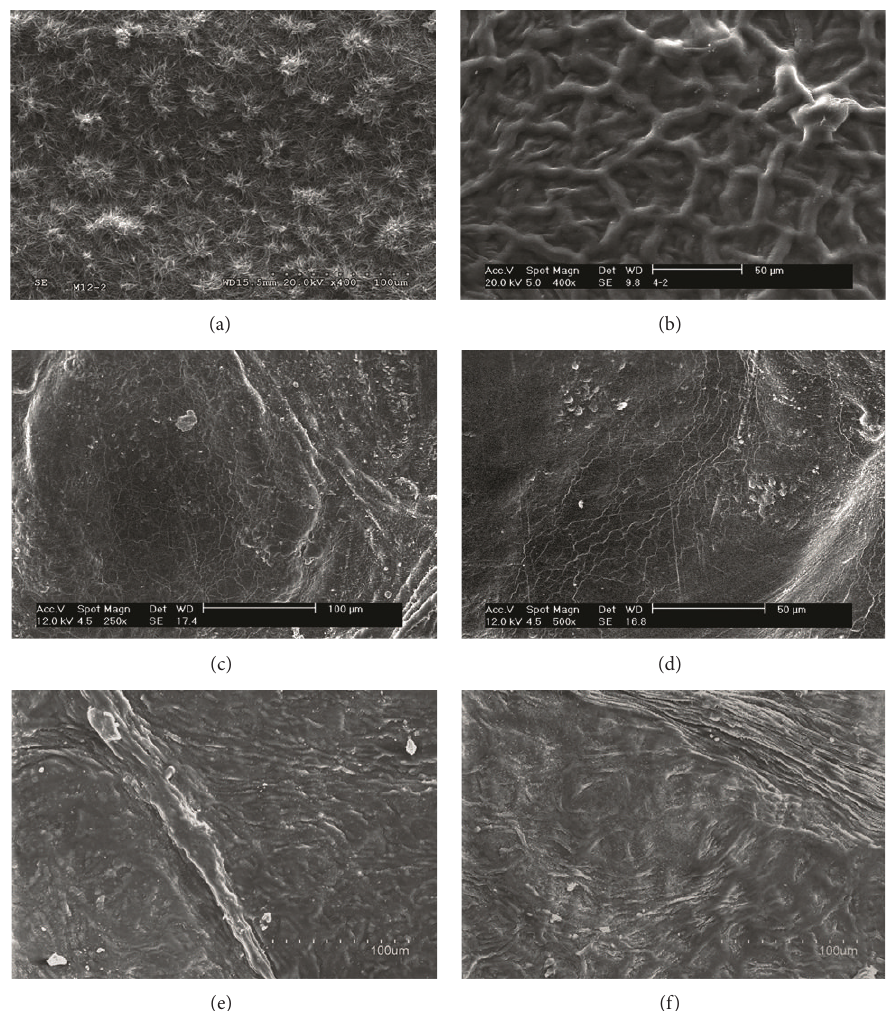
Figure 2: Influence of enzymatic digestion on the outer surface of eucalypt, poplar, and pear adaxial cuticles (b, d, and f) as compared to intact leaves (a, c, and e). (a, b): x500; (c–f):